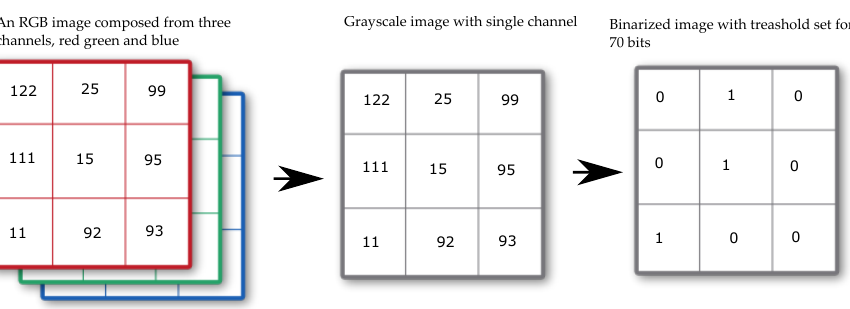
Figure 5. Process of binarization of an RGB